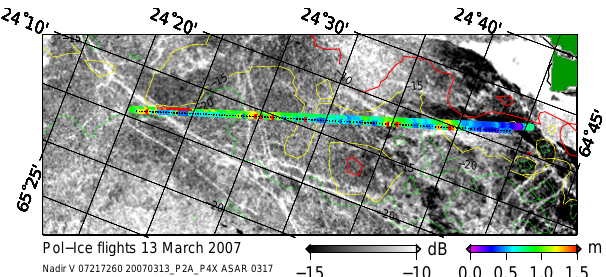
Fig. 5. Flight track of 13 March 2007 and the colour coded thick- ness overlaid on a ASAR WSM image of 17 March 2007. The smaller dots indicate the helicopter EM and the larger dots the Sky- Van EMIRAD measurements. The size of the footprints are not in scale. The bathymetry is indicated with the red (10m), yellow (15m), and green (20m) isolines. The island Hailuto is in the upper right corner in green colour.